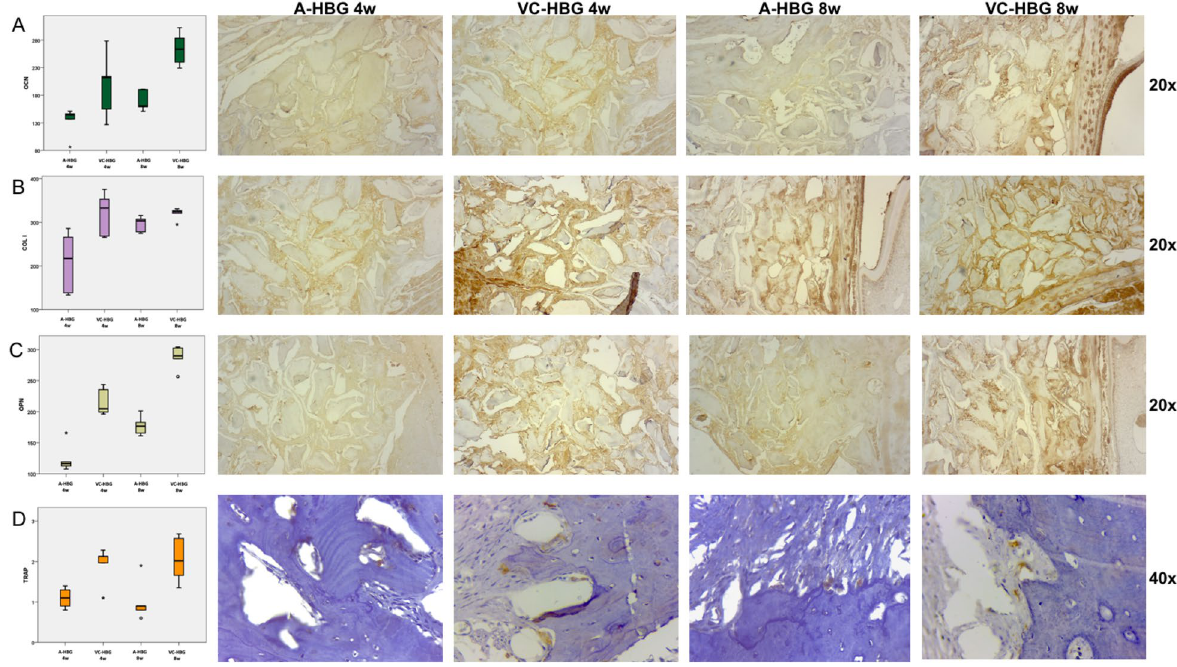
Figure 3. Association between OCN ( A ), COL1 ( B ), OPN ( C ), TRAP ( D ) and graft type at each time point. A-HBG acellular-human bone graft, VC-HBG viable cryopreserved-human bone graft, OCN osteocalcin, COL1 collagen type 1, OPN osteopontin, TRAP tartrate-resistant acid